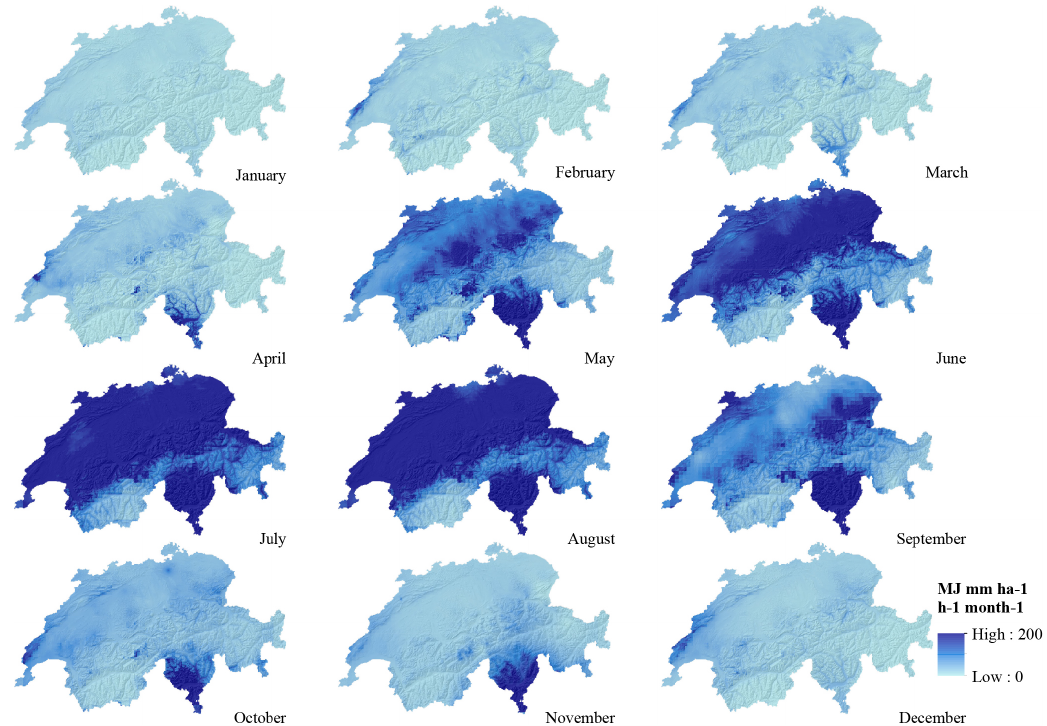
Figure 3. Monthly rainfall erosivity maps for Switzerland (equal stretch from 0 to 200MJmmha − 1 h − 1 month − 1 ) derived by regression– kriging.